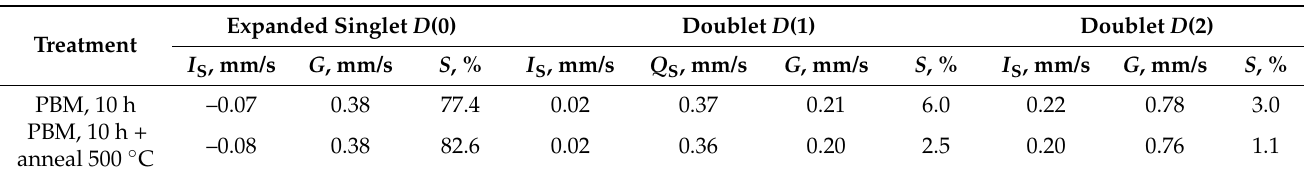
Table 3. Parameters of the hyperfine structure of the MS nitrided austenite obtained in the mix- ture